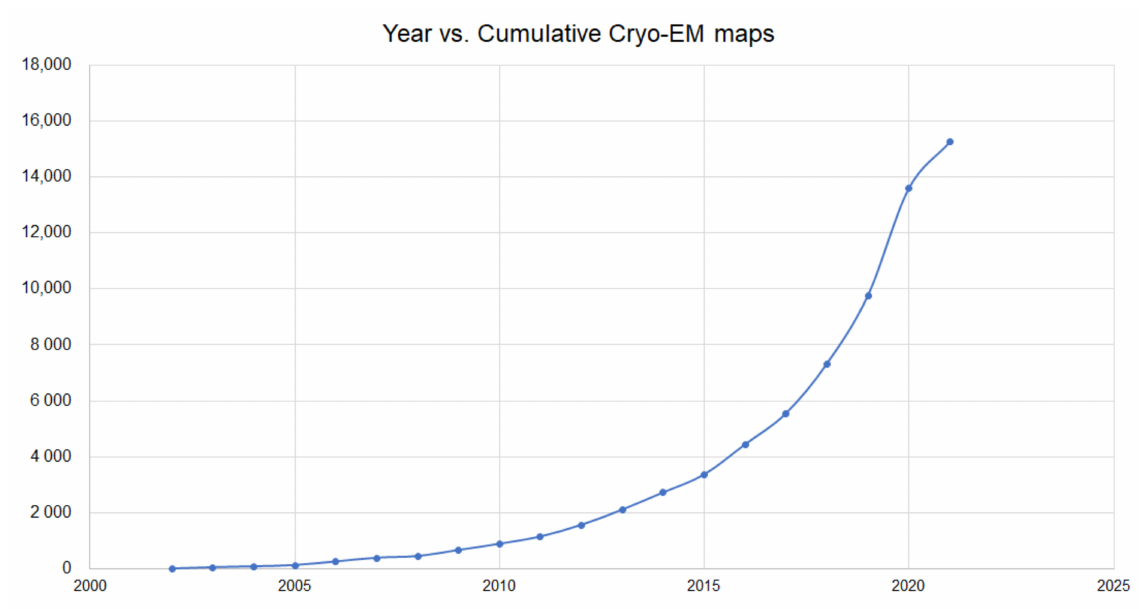
Figure 2. Growth of EMD density maps in EMDB from 2002 to